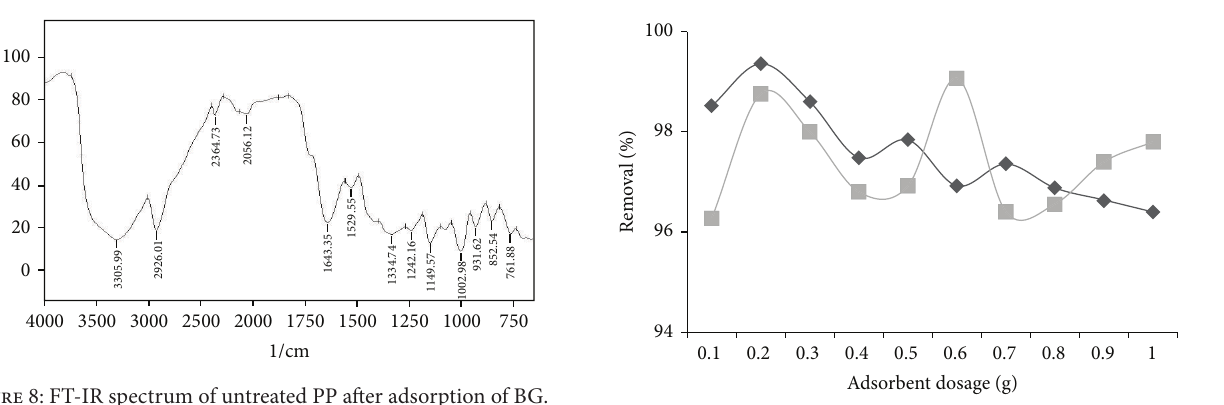
of O–H in untreated and treated PP after adsorption of BG, respectively. Bands at 1244.09 cm −1 and 1149.57 cm −1 were observed due to stretching of C–O group in untreated PP which were shifted to lower shift at 1242.16 and 1151.50 cm in treated PP and then not change after adsorption of BG, respectively. Band at 2360.87 cm −1 was observed due to silane which was shifted to higher wave number at 2364.73 cm −1 .